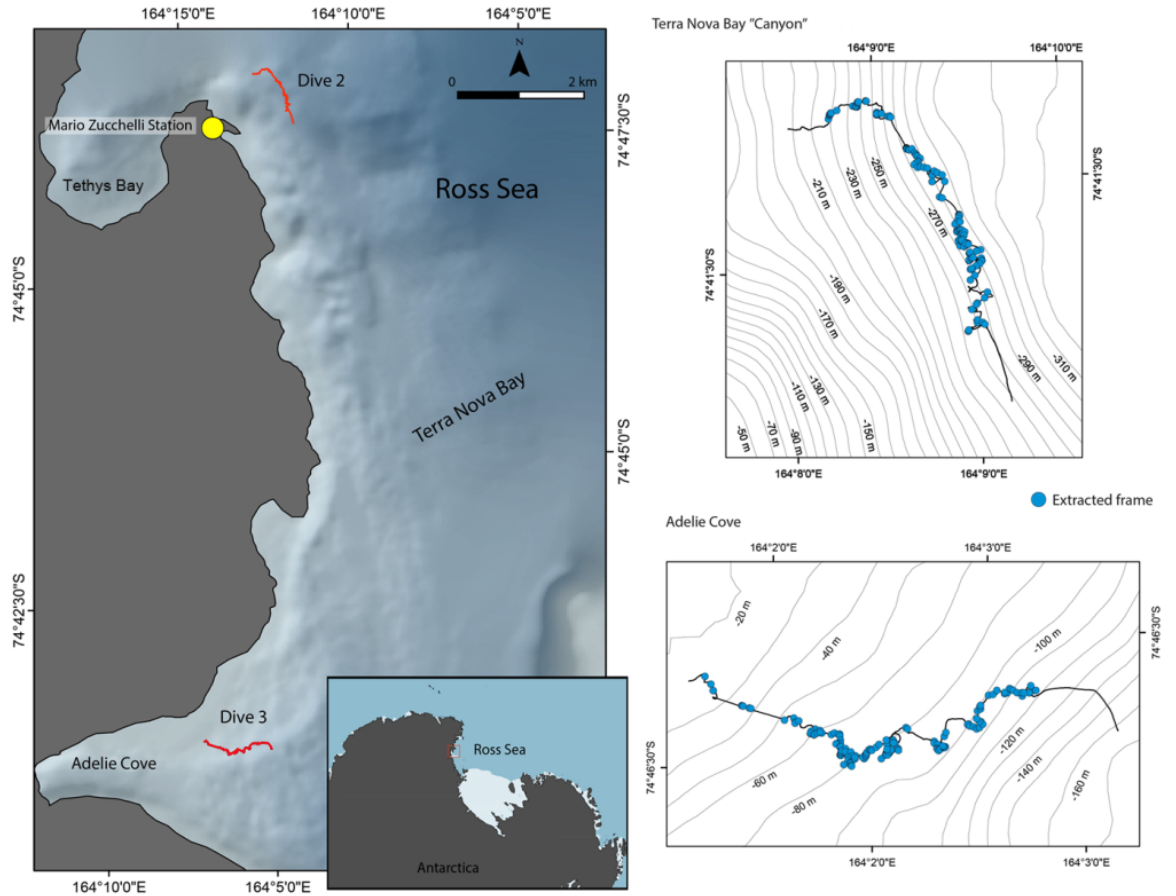
Figure 1. Map of the study area, showing the location (in red on the left) and pathway of the ROV transects (on the right). The figure was partially redrawn from [16], with the kind permission of the authors.